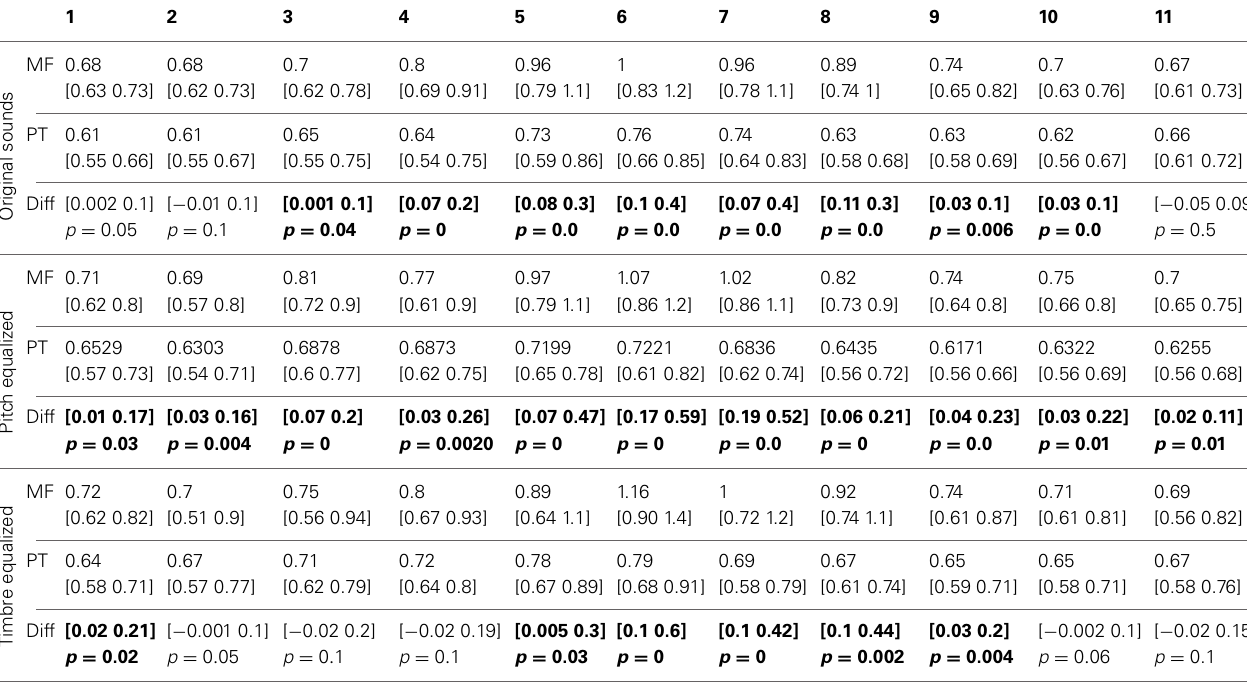
Table 4 | Trimmed mean RTs and 95% CI for each task and condition, with 95% confidence intervals and p -values of differences between tasks.